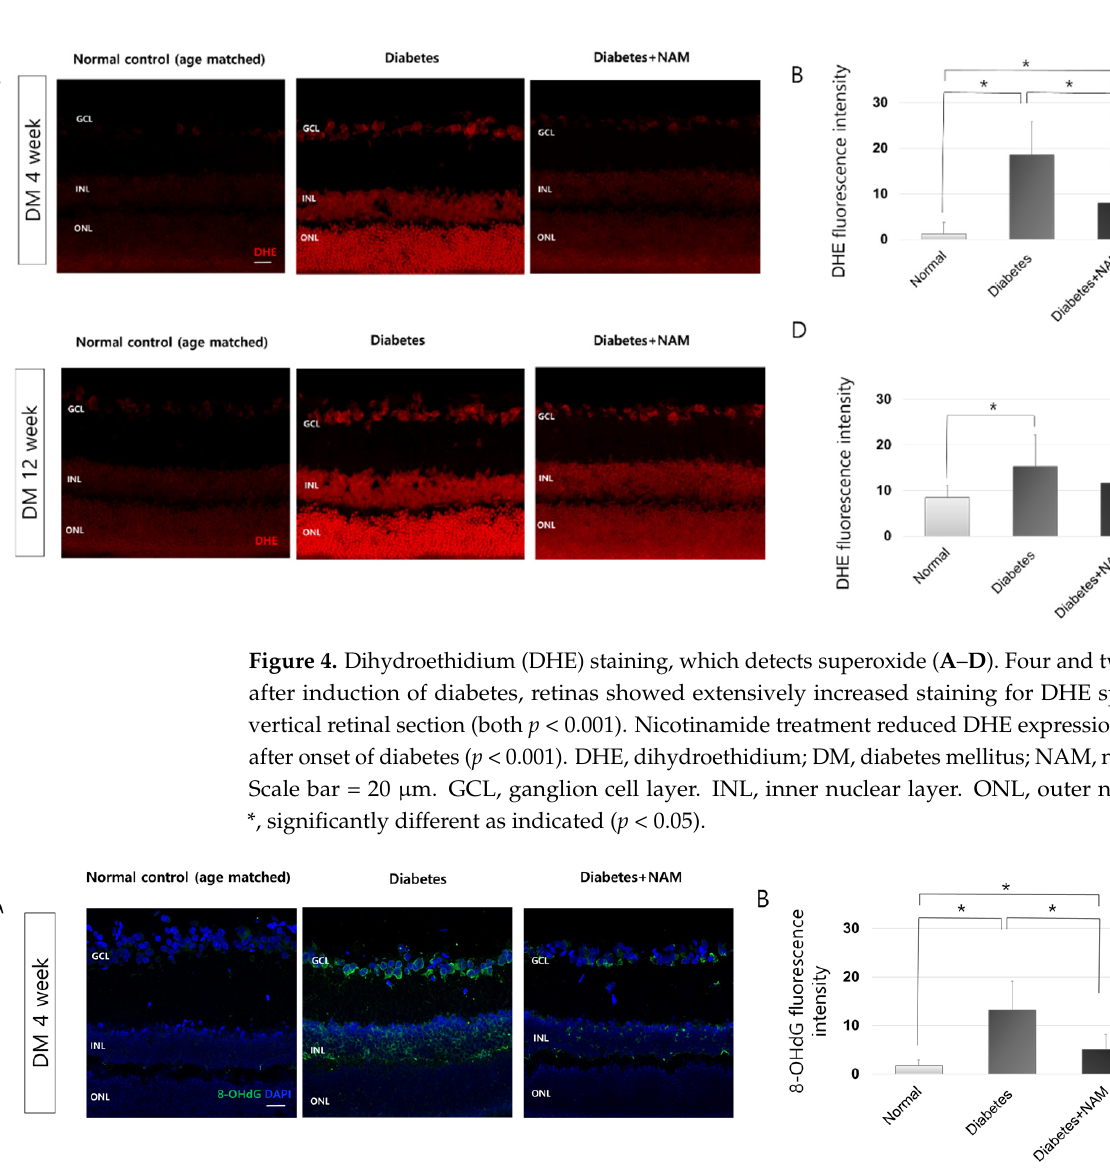
Figure 4. Dihydroethidium (DHE) staining, which detects superoxide ( A – D ). Four and twelve weeks after induction of diabetes, retinas showed extensively increased staining for DHE spanning the vertical retinal section (both p < 0.001). Nicotinamide treatment reduced DHE expression at 4 weeks after onset of diabetes ( p < 0.001). DHE, dihydroethidium; DM, diabetes mellitus; NAM, nic- otinamide. Scale bar = 20 µm . GCL, ganglion cell layer. INL, inner nuclear layer. ONL, outer nuclear layer. *, significantly different as indicated ( p < 0.05).